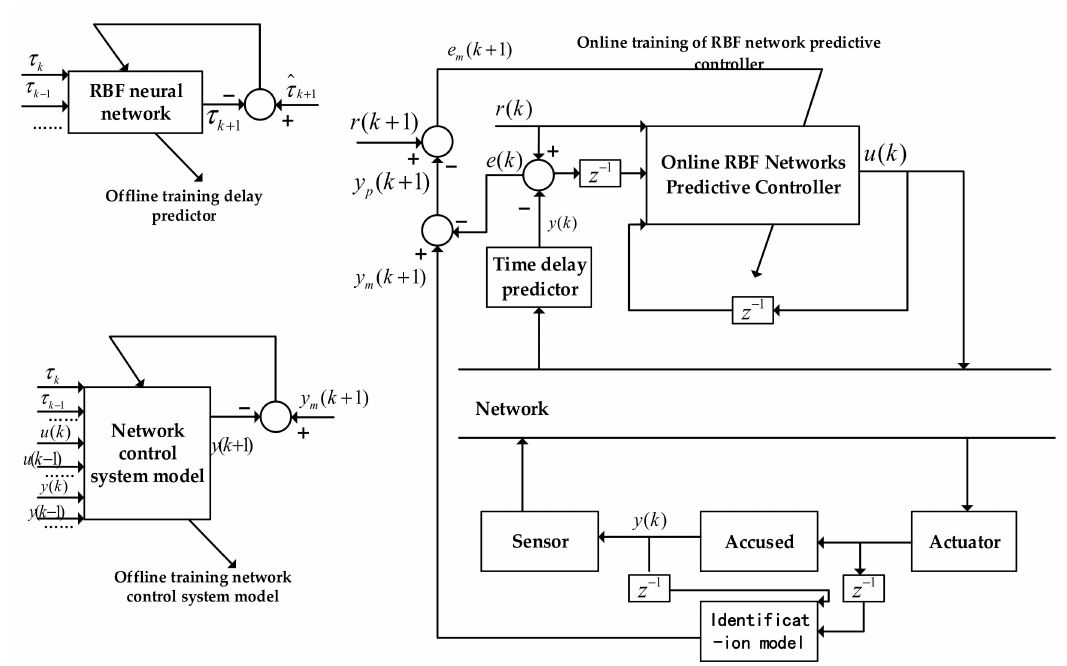
Figure 6. Overall system architecture